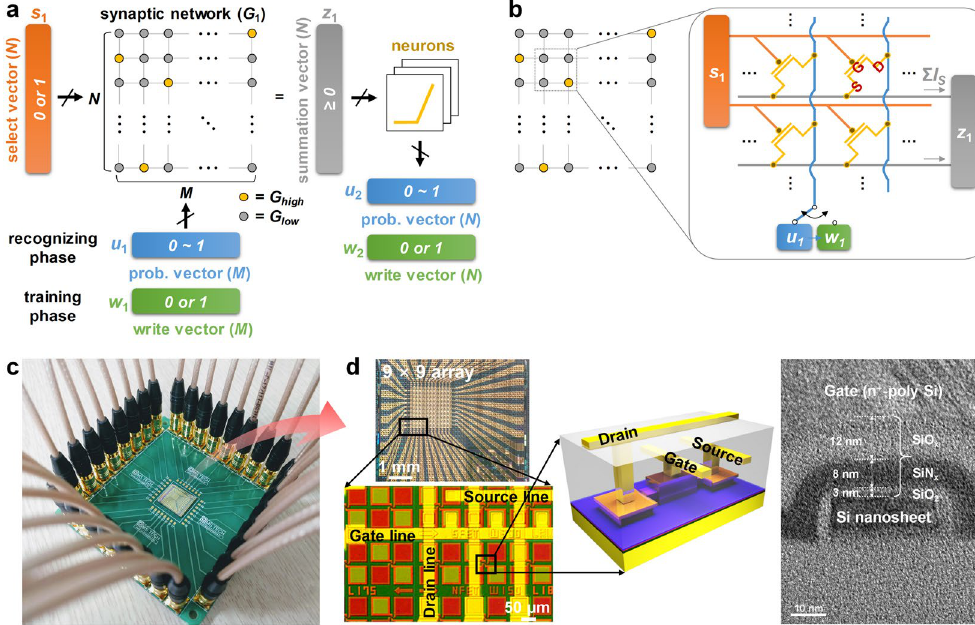
Figure 1. ( a ) The architecture of the binary neural network with M inputs and N outputs. The input pattern information corresponds to the u 1 ( i ) and w 1 ( i ), the s 1 ( i ) enables supervised training by selecting a specific row, and the